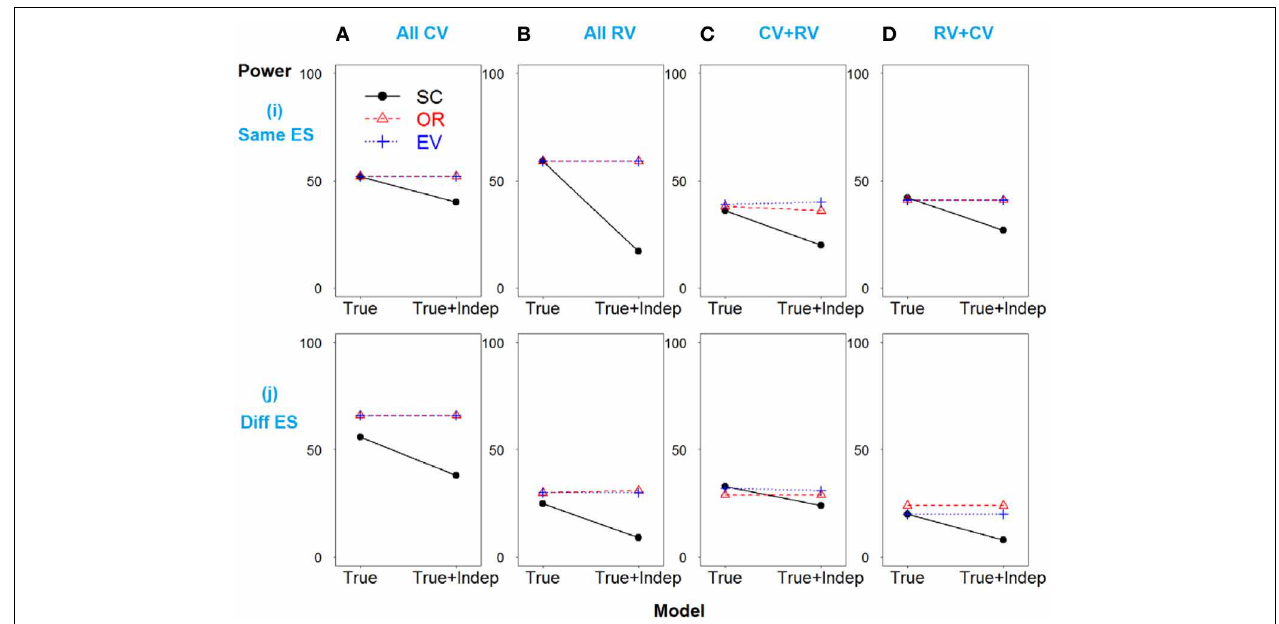
FIGURE 4 | Power comparison for the weak linkage disequilibrium model when SNPs 2 and 3 are independent. Panels by column: (A) SNPs 1 and 2 are common variants. (B) SNPs 1 and 2 are rare variants. (C) SNP 1 is